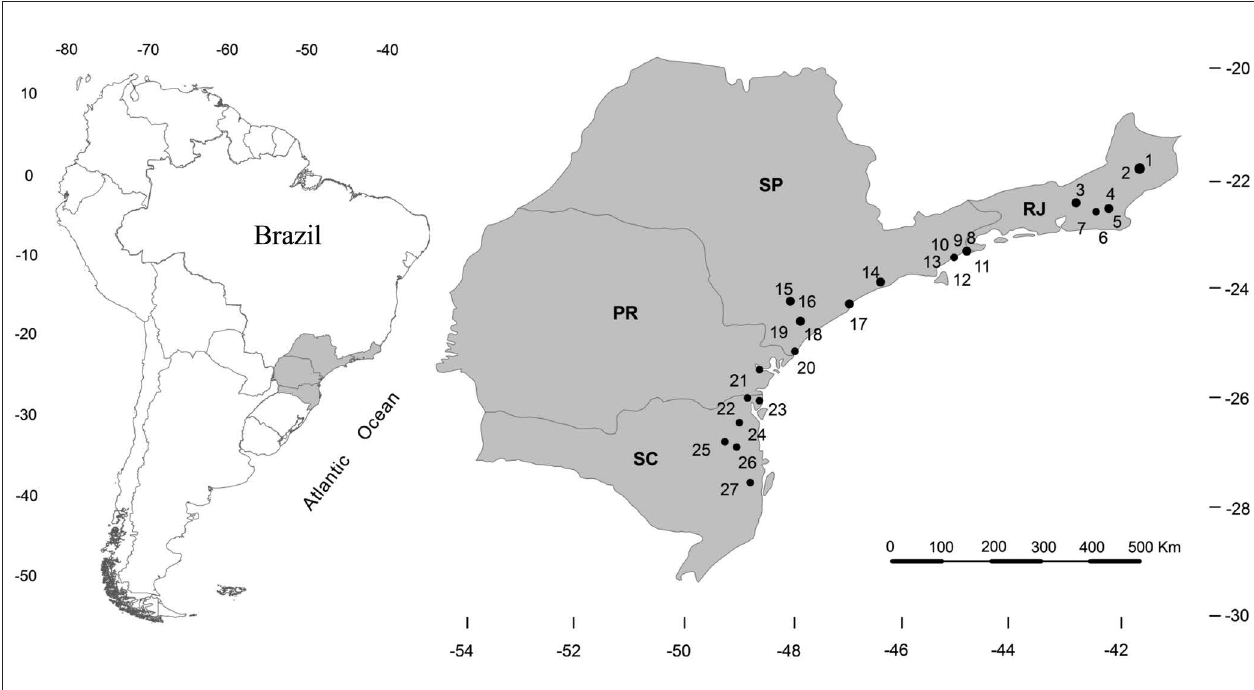
Figure 1 – Map showing the distribution of the sample areas (1 to 27) along the coastal region of the southeastern Atlantic Forest. RJ = Rio de Janeiro State, SP = São Paulo, PR = Paraná and SC = Santa